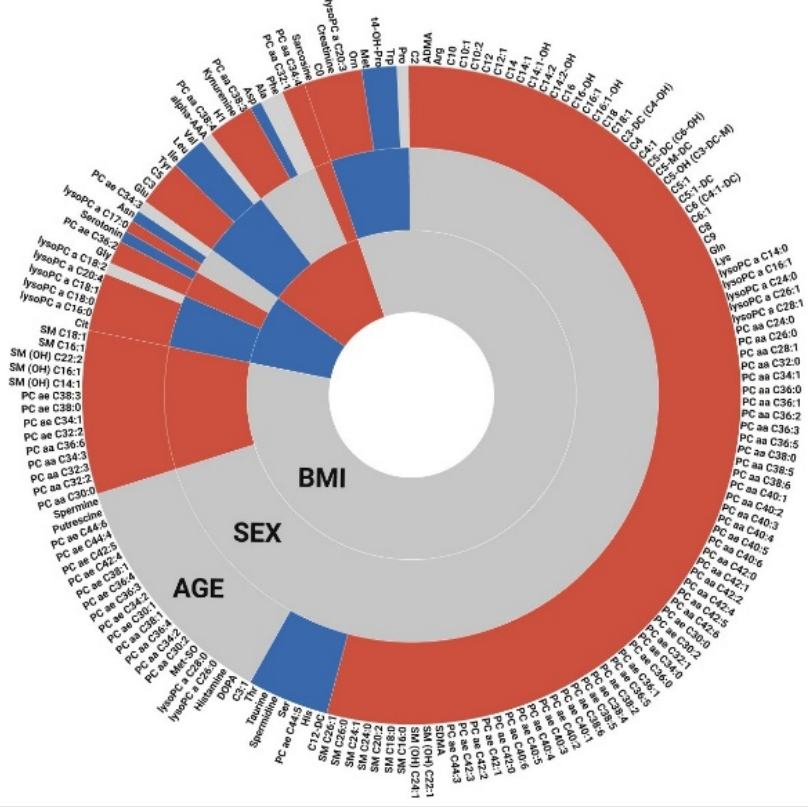
Figure 4. Overview on metabolites related to age, sex, and BMI. Gray spaces represent non ‐ significant metabolites, while blue and red colors represent negative and positive coefficients, respectively. For sex ‐ related metabolites, female is considered the baseline, i.e., metabolites with higher concentrations in male participants are colored in red (and vice versa). For BMI ‐ related metabolites, the results from the comparison of obese against normal are shown.